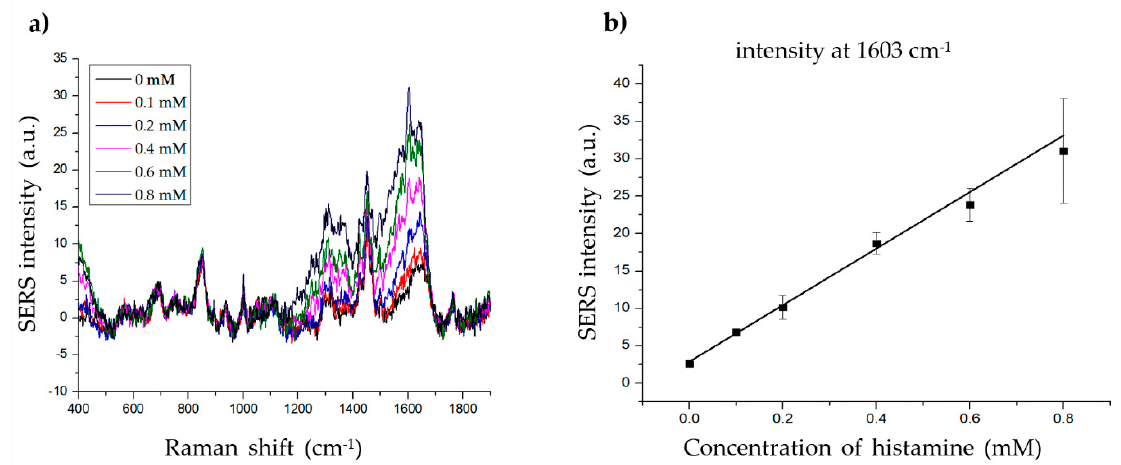
Figure 6. Determining the limit of detection (LOD) of histamine. ( a ) The Raman signal of histamine at different concentrations (0, 0.1, 0.2, 0.4, 0.6, and 0.8 mM). ( b ) The standard linear plot of histamine concentration vs. SERS intensity at 1603 cm − 1 .